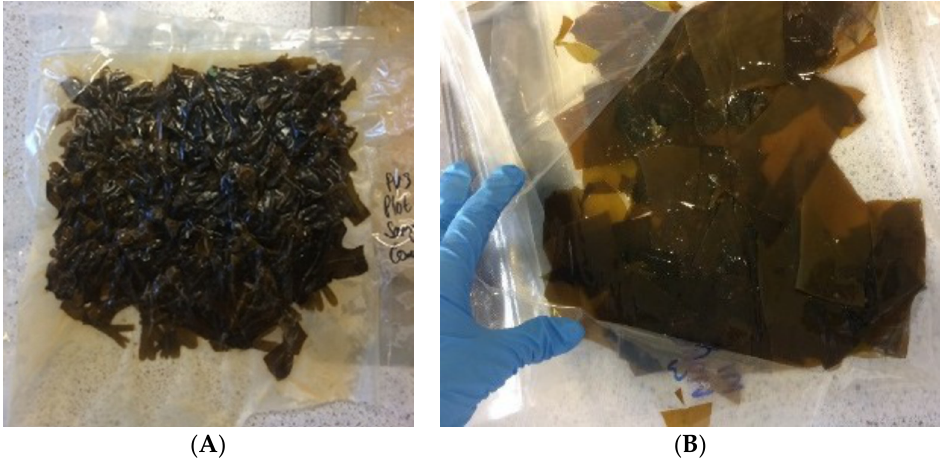
* Inoculant indicates the interaction of effects. a,b,c Means with different superscripts are significantly different ( p < 0.05); SEM = standard error of the mean.